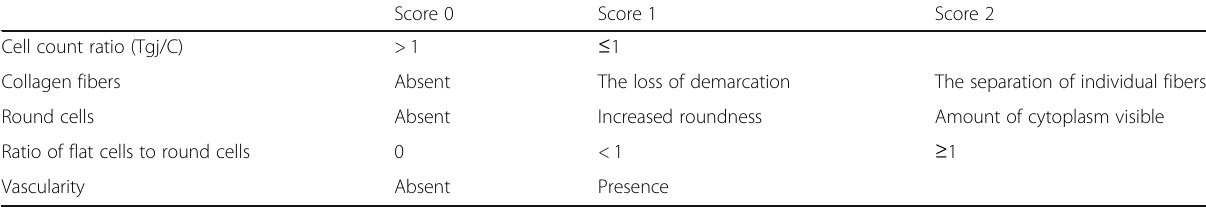
Table 1 Maturity scores of the tendon gel